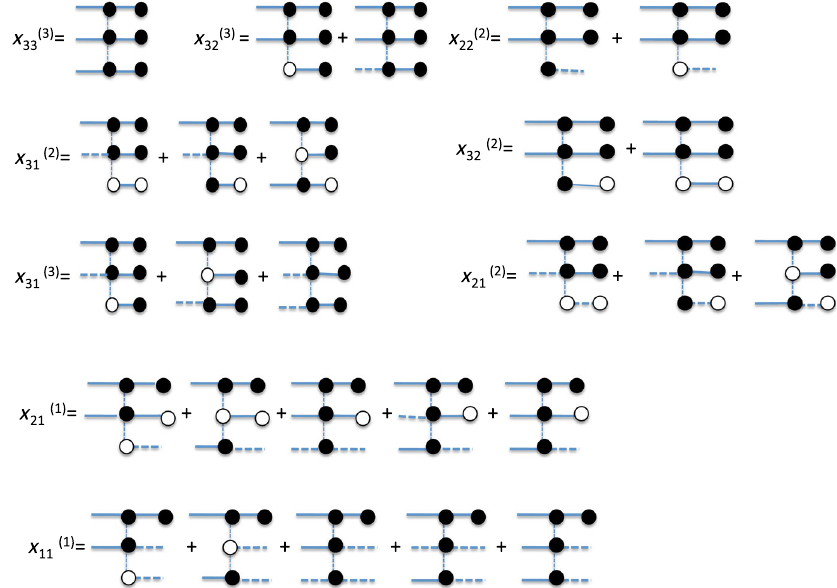
ξ Þ FIG. 8. Diagrams for Eqs. (33) determining x ð μν in the case of multiplex networks with three layers ( M ¼ 3 ) and Poisson multidegree distribution with h k ð 1 ; 1 ; 1 Þ i ¼ z 3 , h k ð 1 ; 1 ; 0 Þ i ¼ h k ð 1 ; 0 ; 1 Þ i ¼ h k ð 0 ; 1 ; 1 Þ i ¼ z 2 and h k ð 1 ; 0 ; 0 Þ i ¼ h k ð 0 ; 1 ; 0 Þ i ¼ h k ð 0 ; 0 ; 1 Þ i ¼ z 1 .